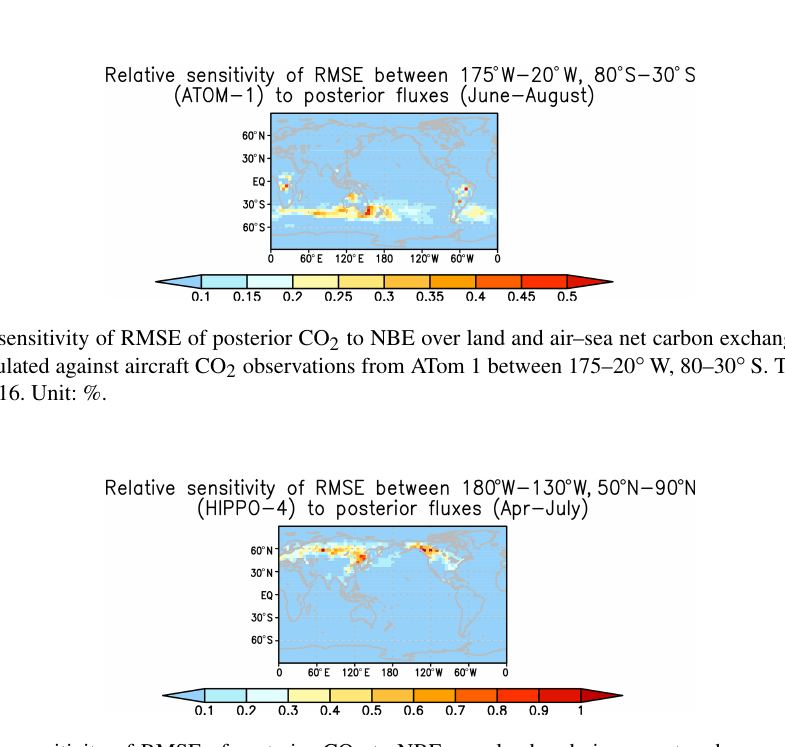
Figure B10. The relative sensitivity of RMSE of posterior CO 2 to NBE over land and air–sea net carbon exchange over ocean at every grid point. The RMSE is calculated against aircraft CO 2 observations from HIPPO 4 between 180–130 ◦ W, 50–90 ◦ N. The adjoint model is carried out over April–July 2011. Unit: